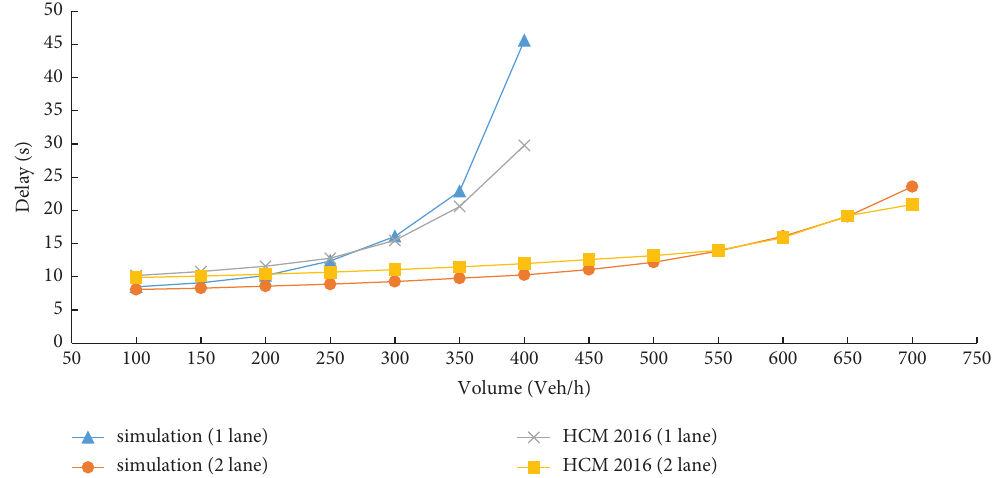
Figure 11: Delay variations of the efect of changing trafc scenarios in a single and dual left-turn lane.